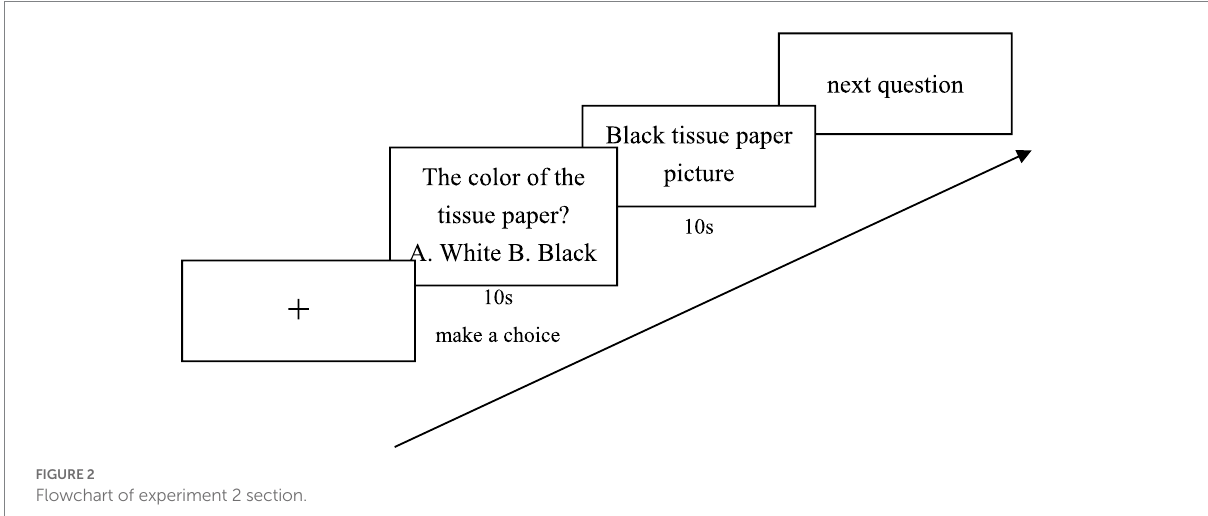
FIGURE 2 Flowchart of experiment 2